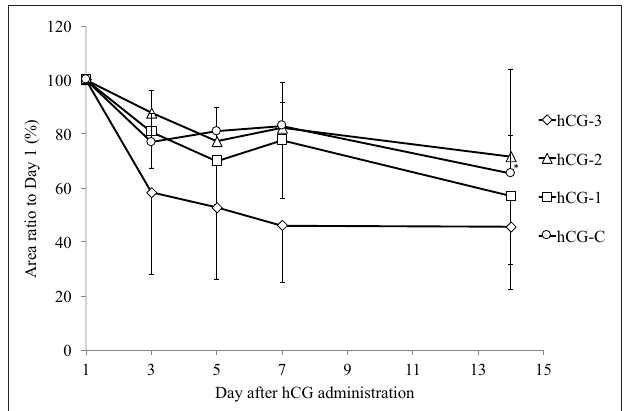
FIGURE 4 | Serum P4 concentration (mean ± SEM) of each hCG group. a,b, a tendency ( P = 0.07) for a difference between the hCG-1 and hCG-C groups was observed. *A tendency for an increase in P4 concentrations was observed in the hCG-1 ( P = 0.054) and hCG-2 ( P = 0.051) groups at day 14 compared with day